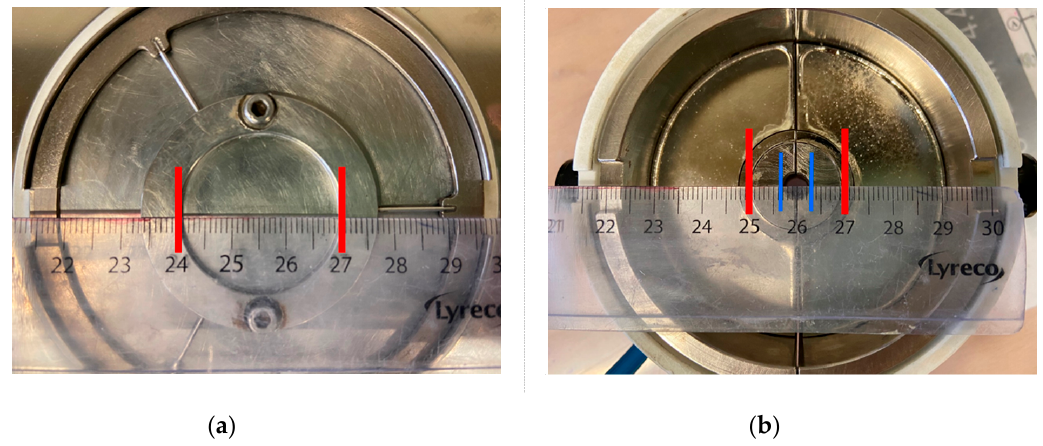
Figure 4. Geometrical parameters of ( a ) the bottom plate of the rheometer and ( b ) the upper yoke of the magneto-rheological device.